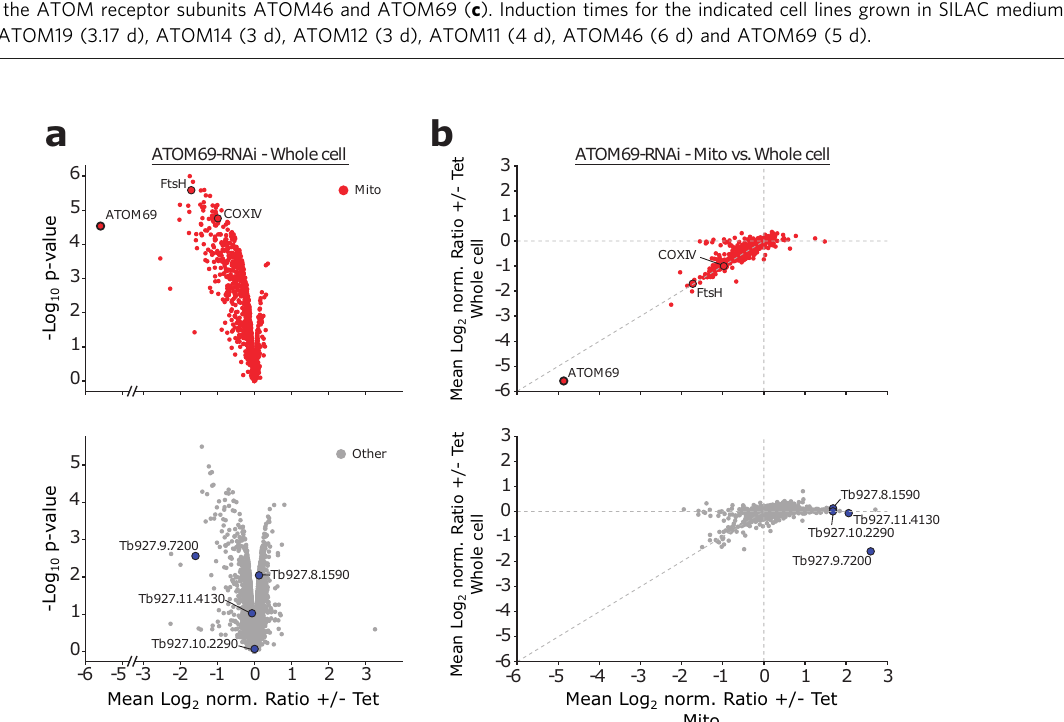
Fig. 2 Ablation of ATOM69 stimulates recruitment of proteins to the mitochondrion. a Whole cellular extracts of uninduced and induced ATOM69- RNAi cells were subjected to stable isotope labelling by amino acids in cell culture (SILAC)-based quantitative mass spectrometry (MS). Top, volcano plot depicting mitochondrial proteins (red dots) as de fi ned in 52 . The model substrates FtsH and cytochrome oxidase subunit IV (COXIV) are highlighted. Bottom, volcano plot depicting other proteins (grey dots). Highlighted in blue are the four putative non-mitochondrial candidate proteins that were further studied. b Ratio plots depicting changes in protein levels in crude mitochondrial fractions (Mito) versus whole cell extracts of ATOM69 RNAi experiments. Proteins are labelled as in a